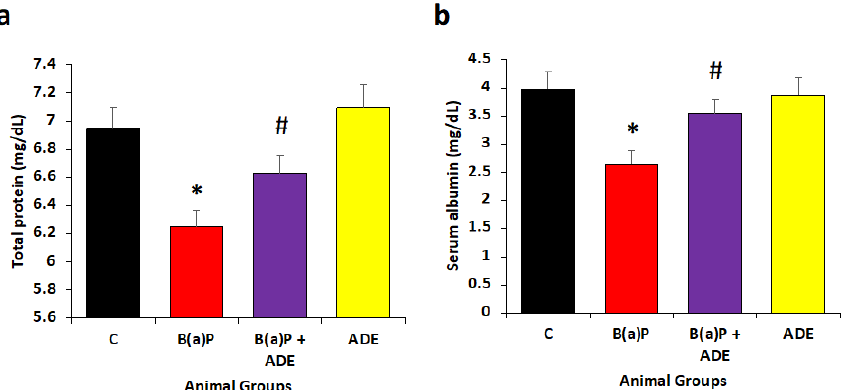
Figure 5. The level of ( a ) total proteins and ( b ) serum albumin levels decreased in B(a)P-treated group. The total protein and albumin levels significantly increased in the ADE treatment group. The numbers signify the mean ± SEM with 8 animals per group. The statistical differences are represented with asterisk (*) representing significance at ( p < 0.05) as compared to the normal control group and hash (#) represents ( p < 0.05) as compared with B(a)P-treated group only.